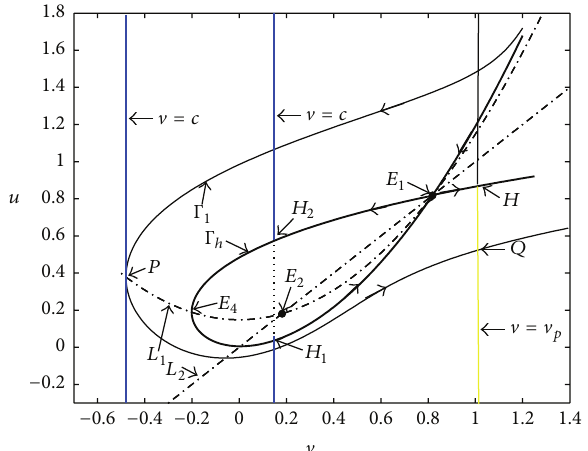
Figure 1: Illustrations of the domains of phase set and impulsive set for case (𝐴 1 ) . The blue lines represent the phase sets and the yellow line denotes the impulsive set.